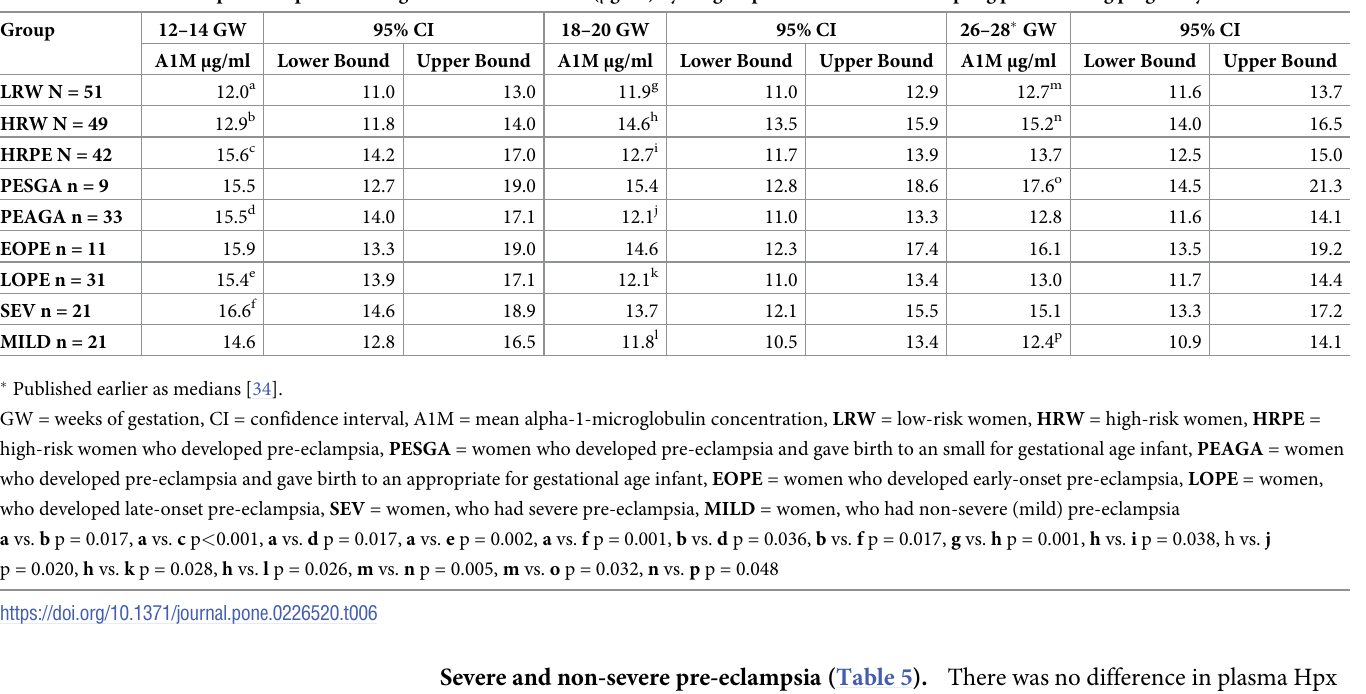
Severe and non-severe pre-eclampsia (Table 5). There was no difference in plasma Hpx concentrations between high-risk women with severe PE and high-risk women with non- severe PE neither before (main effect Group p = 0.933, interaction effect Time x group p = 0.726) nor after adjustment for BMI (main effect Group p = 0.378 and interaction effect Time x group p = 0.759). When analyzed separately at each sampling point, the Hpx concen- trations of women who developed non-severe PE were higher than in LRW at 26–28 GW (1.22 vs. 1.03 mg/ml, respectively, p = 0.029).